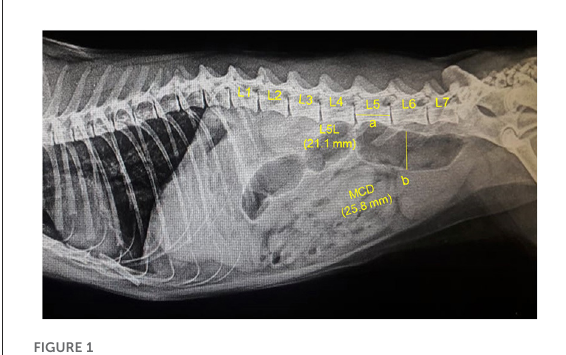
FIGURE2 A representative lateral abdominal plain radiograph of a 6.9-years-old 4.6-kg domestic shorthair castrated male cat with idiopathic megacolon and constipation/obstipation. Measurements for the body length of the fifth lumbar vertebra (L5L, labeled a, 21.7mm), and maximum colon diameter (MCD, labeled b, 40.5mm) are displayed by solid yellow